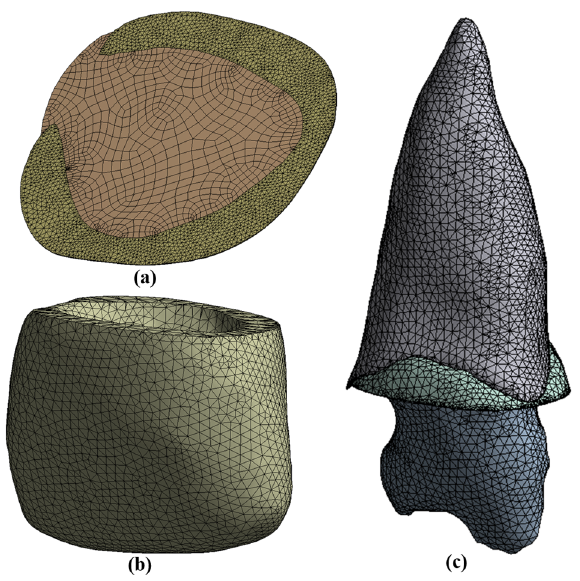
Figure 3. Meshes: ( a ) Adhesive material, ( b ) lower part of crown fracture, and ( c ) upper part of crown fracture.